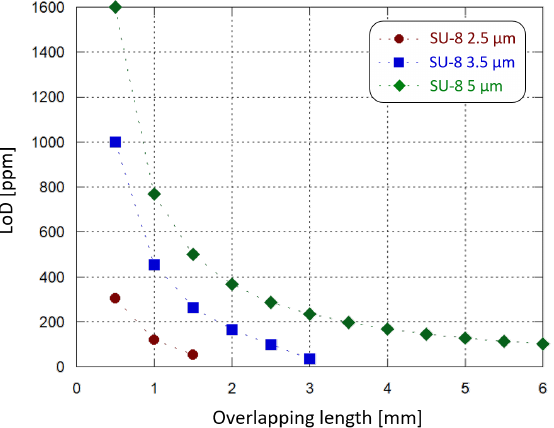
Figure 11. Sensing demonstration: limit of Hb concentration detection (inside the considered 10.4– 16.5%range) by the developed system as a function of the waveguide-sample overlapping length, for different SU-8 waveguide